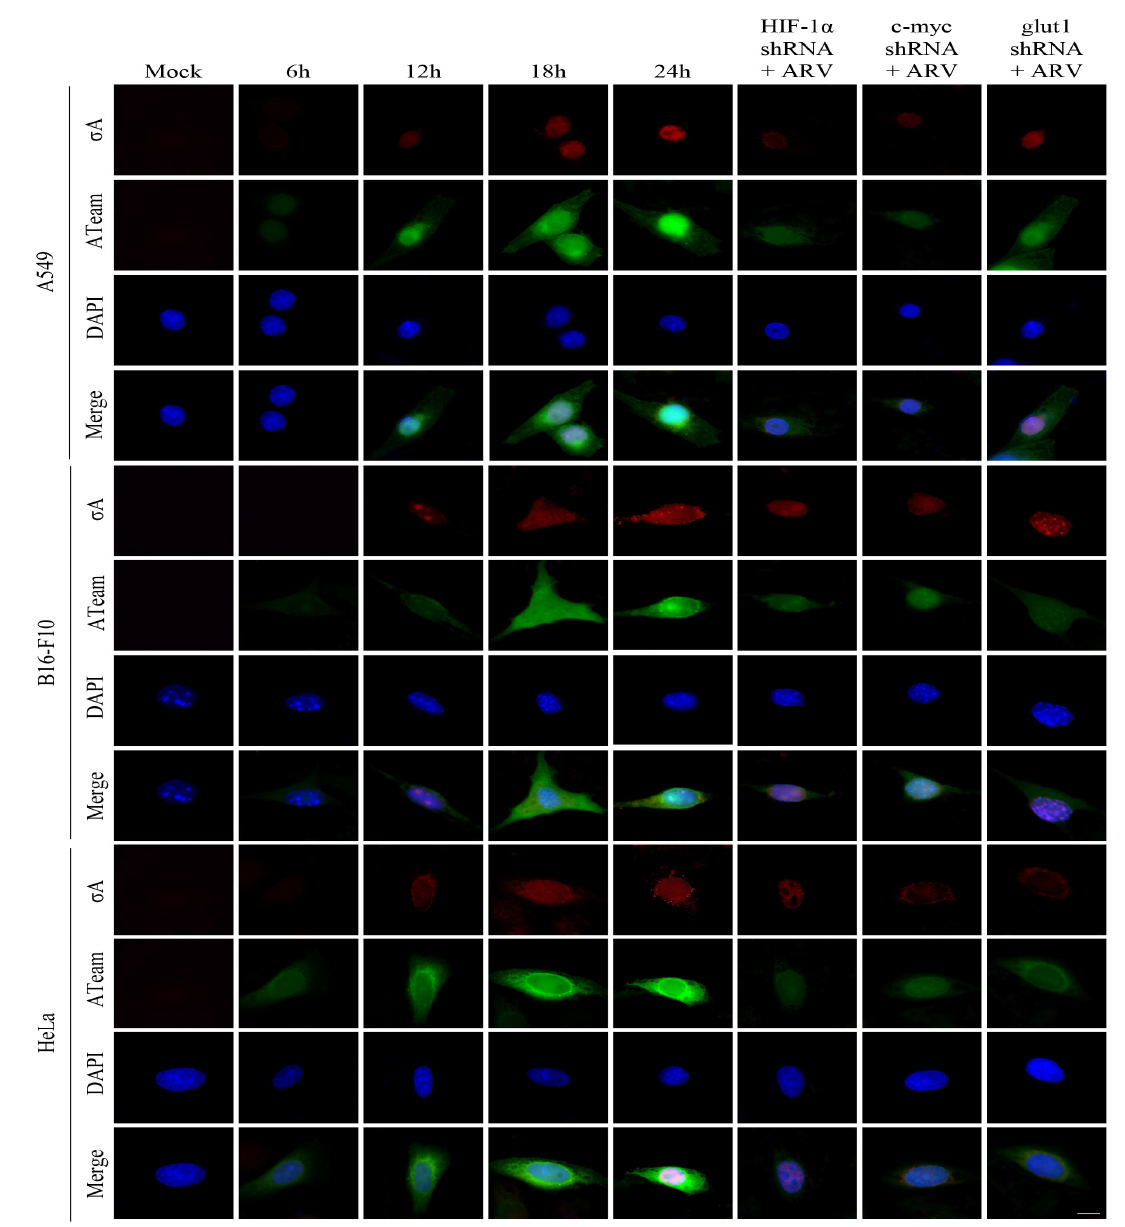
Figure 5. Visualization of adenosine triphosphate (ATP) levels inside cancer cell lines infected with ARV. To measure intracellular ATP levels, the cancer cell lines were transfected with the ATeams with or without c-myc, HIF 1 α , and glut1 shRNAs for 18 h followed infection with ARV at different time points and MOI of 10 as indicated. The cells were observed and photographed with a fluorescence microscope (scale bar, 20 μ m). The fluorescence density was quantitated using Image J software as shown in Supplementary Figure S8A.